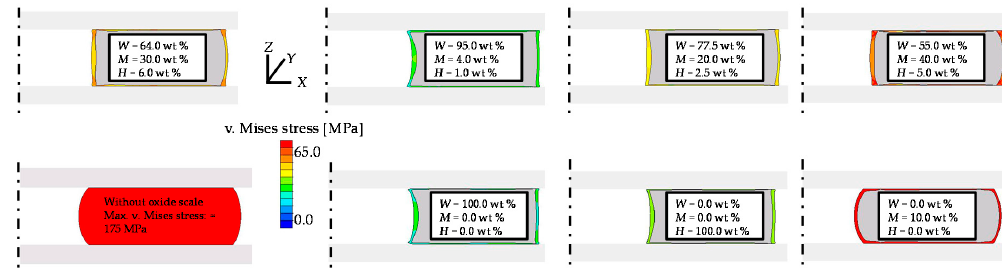
Figure 13. Final component shape and v. Mises stress depending on mass fractions of wuestite ( W ), magnetite ( M ), and haematite ( H ).